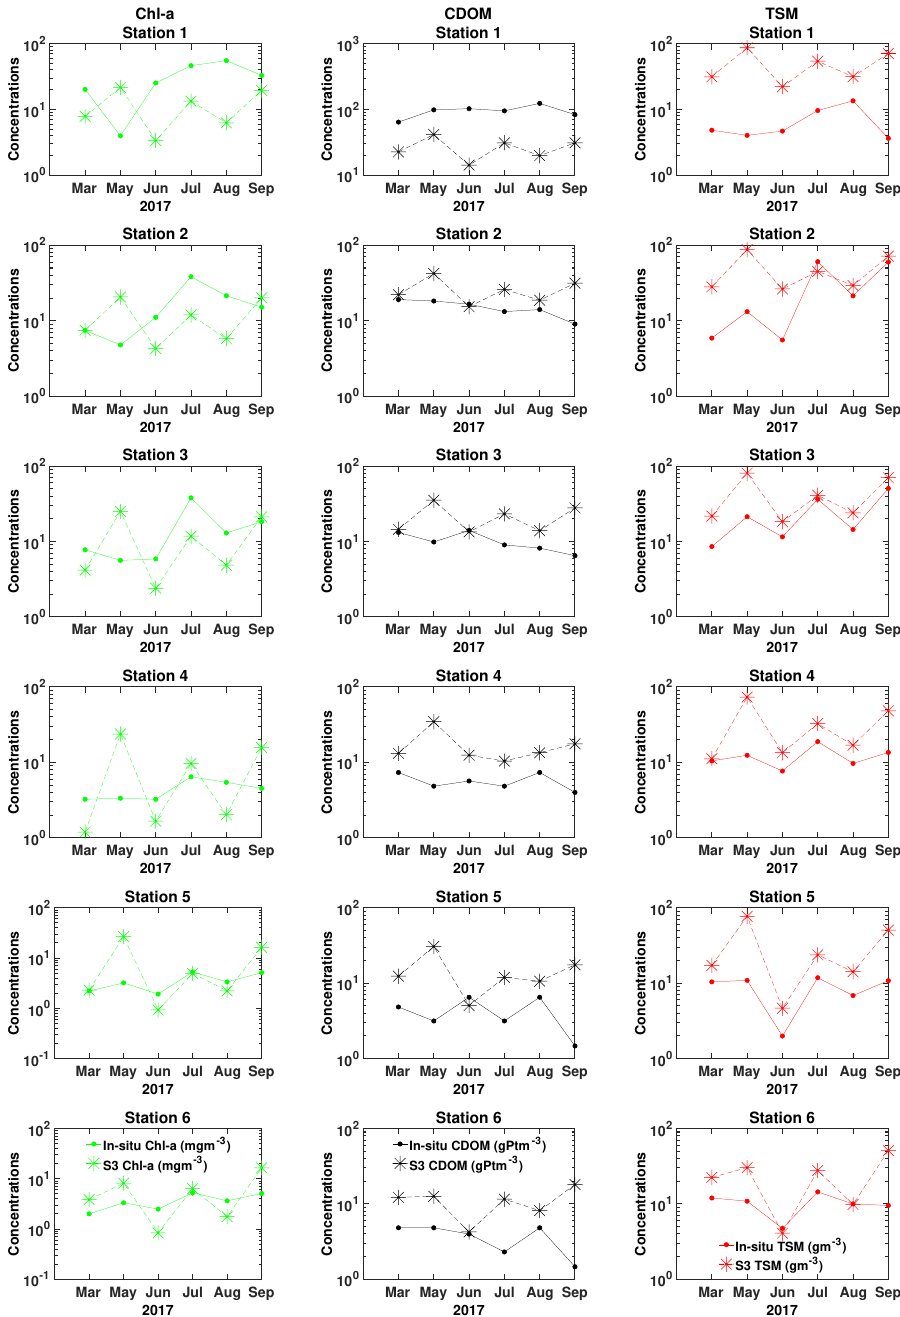
Figure 6. In situ versus satellite-derived water quality products for the stations. Chl-a is shown in the left panel, CDOM in the middle, and TSM in the right panel. Y-axis is presented on a logarithmic scale. Monthly